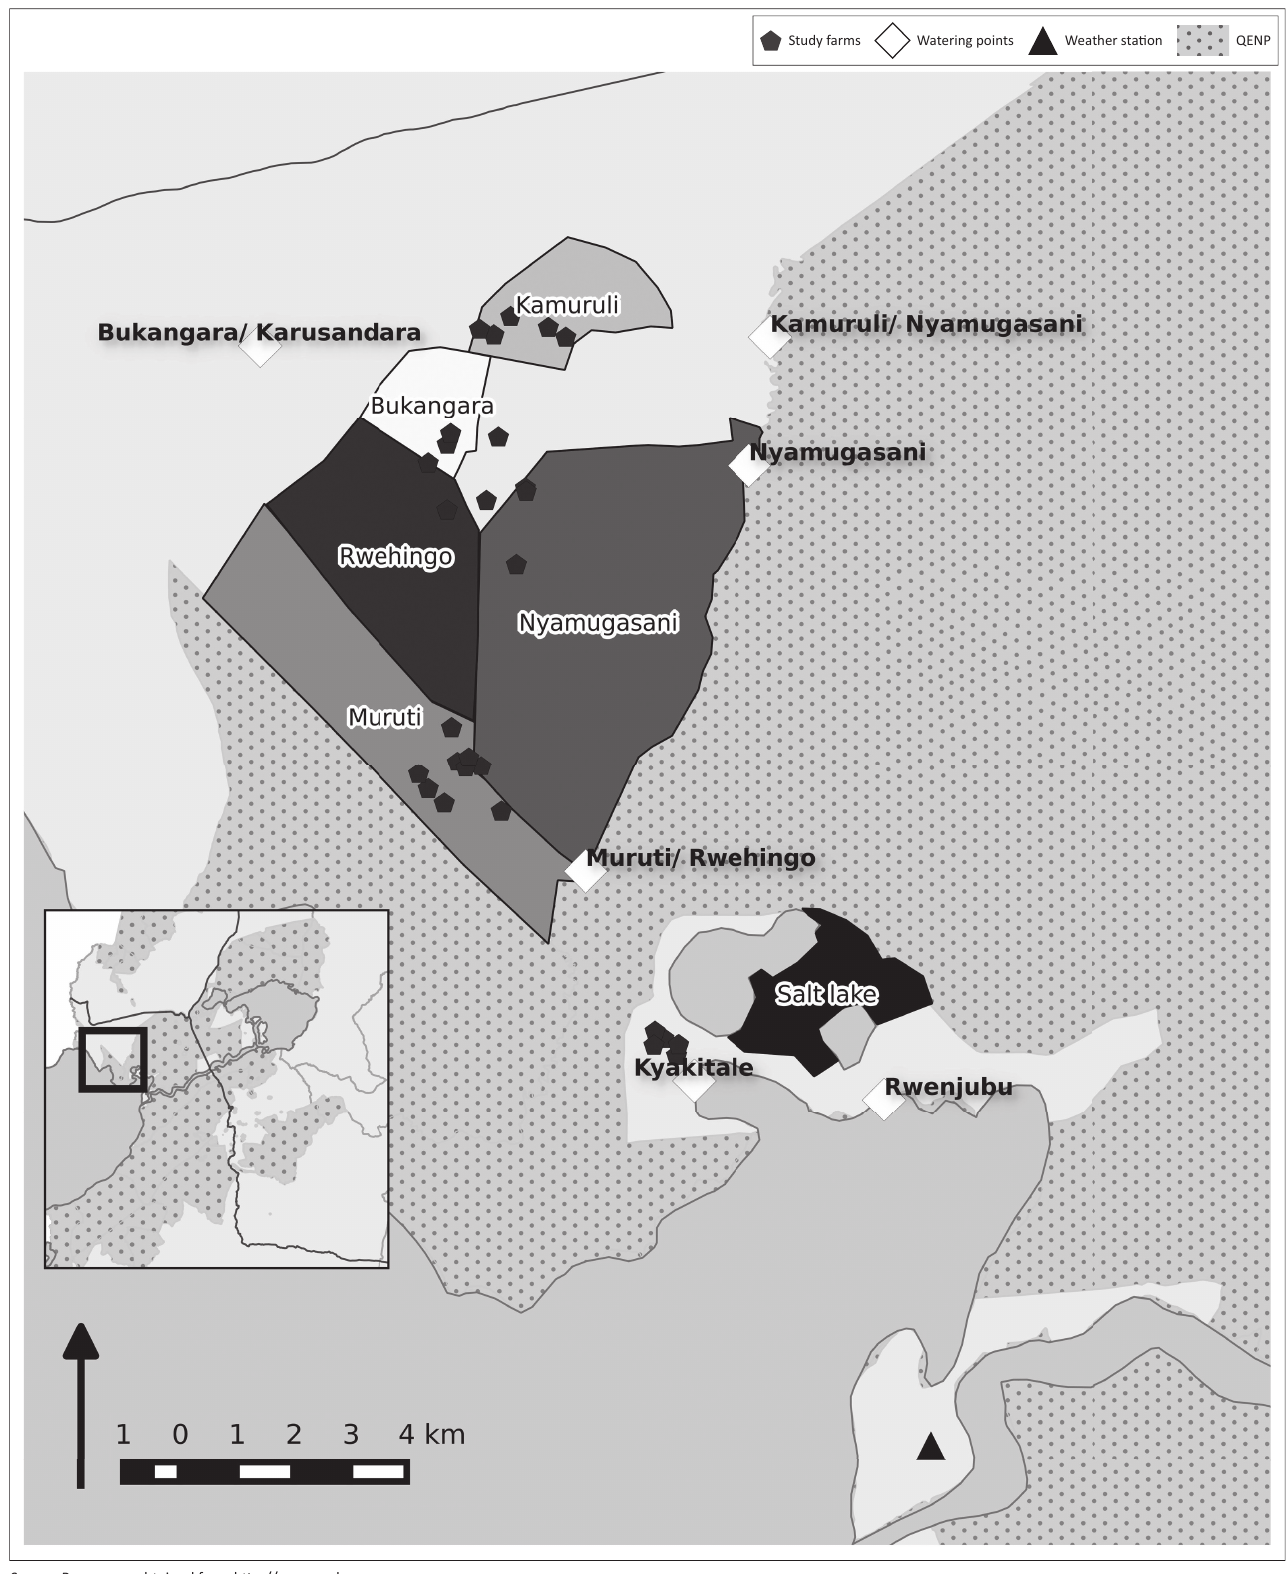
FIGURE 1: Study site in western Uganda showing location of study farms, communal grazing areas and watering sites. Inset: Queen Elizabeth National